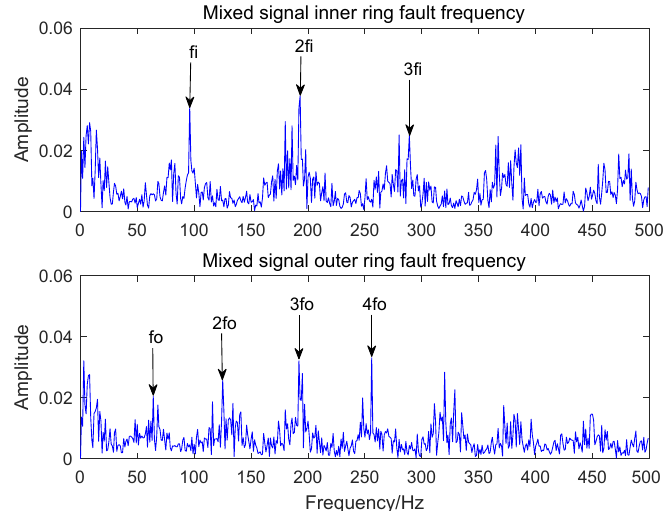
Figure 10. Envelope spectrum results using the ICEEMDAN-MVO-MCKD.